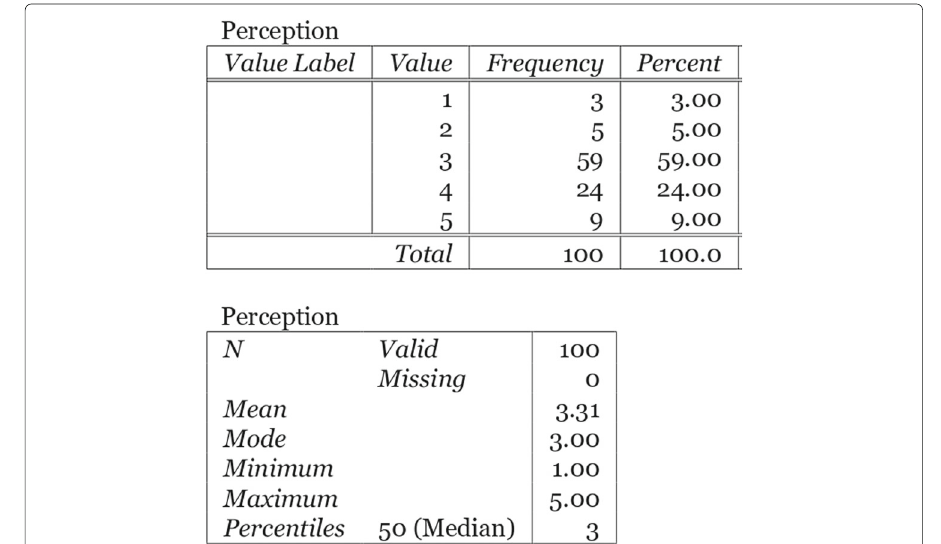
Fig. 14 Students’ own perception of visual/spatial